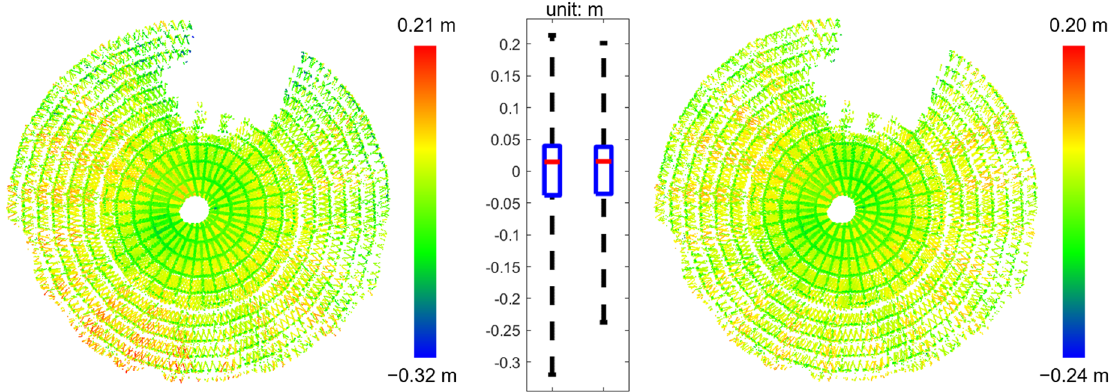
Figure 31. Heat maps and box plots representing the normal distance between the roof feature points and fitted quadratic surface for the Lebanon dataset before (left) and after (right) partial fine registration.